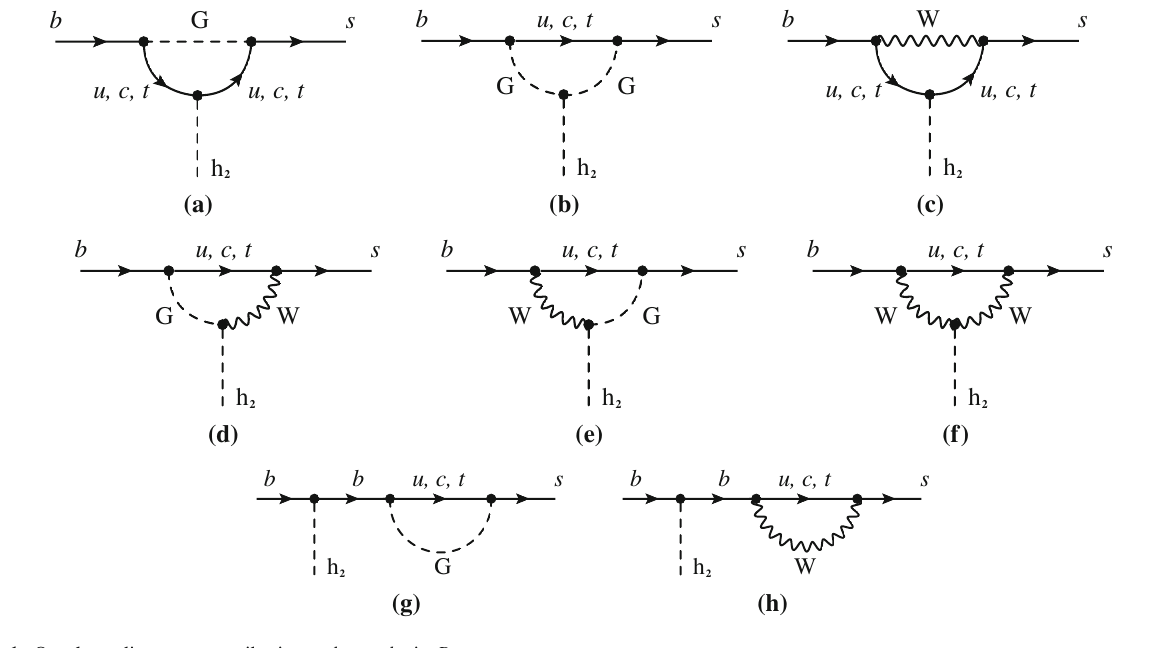
Fig. 1 One-loop diagrams contributing to b → sh 2 in R ξ gauge m 2 1 φ 2 + λ φ φ 4 V φ = 2 4